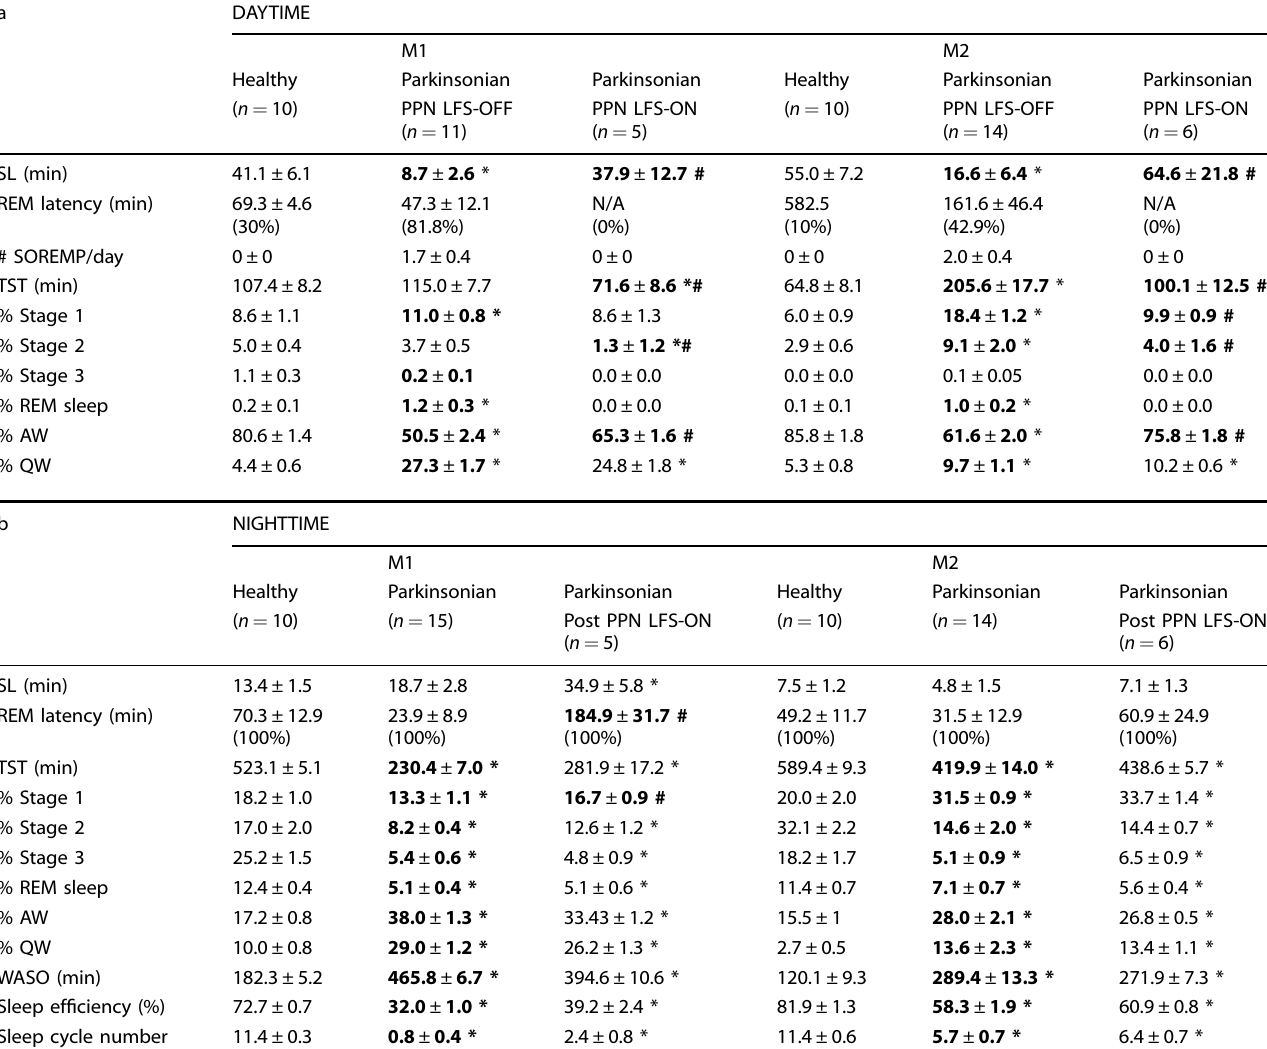
Table 1. Effects of chronic 12 h PPN-LFS on daytime and effects on the following